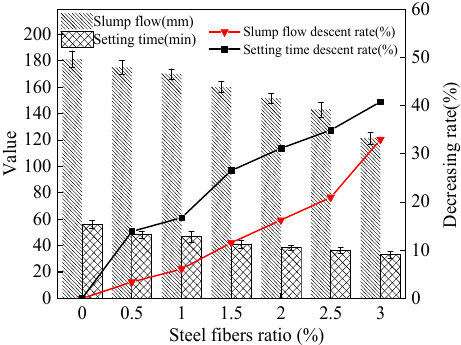
Figure 6. The working performance of MPC-RPC.